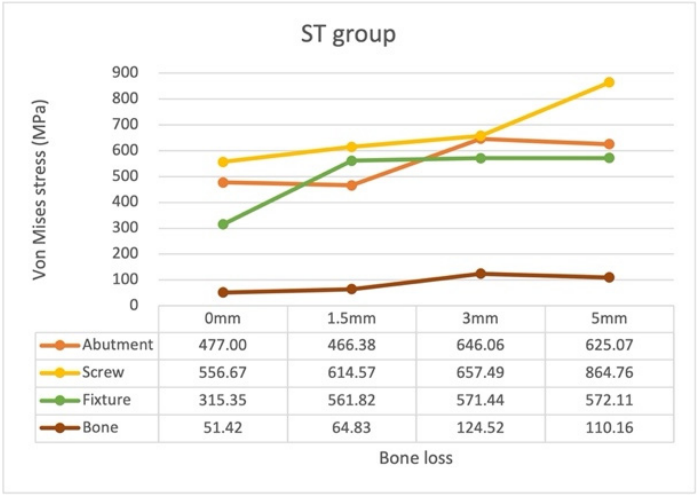
Figure 8. Maximum von Mises stress on the abutment, screw, fixture, and bone in the ST groups with different bone loss levels.